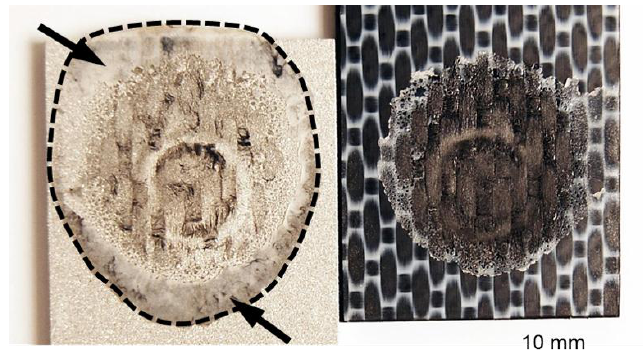
Figure 7. A representative example of the fracture surface of a friction spot joint. The arrows indicate the layer of the reconsolidated molten PPS.